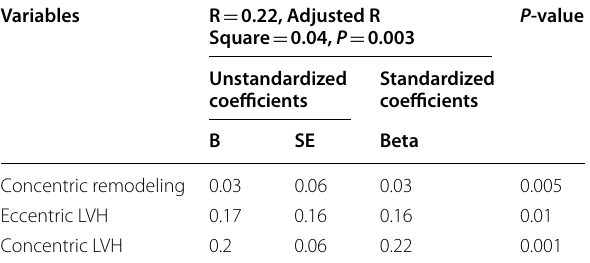
Table 9 Linear Regression Analysis of the abnormal LV geometric patterns to predict CAD-RADS